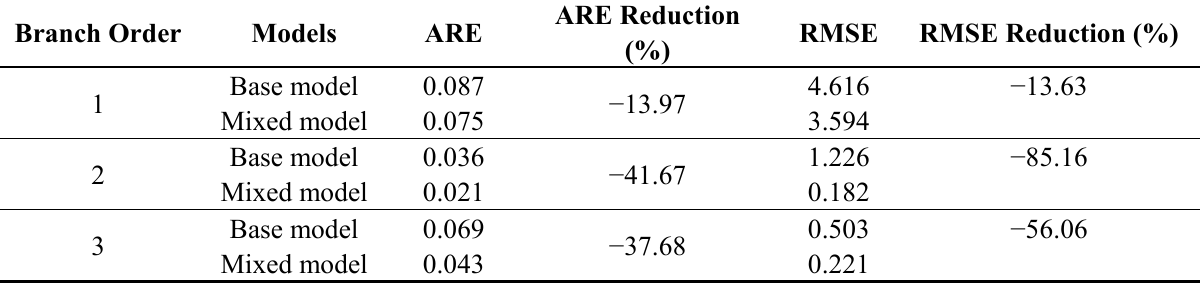
Table 8. Comparison between base model and mixed model